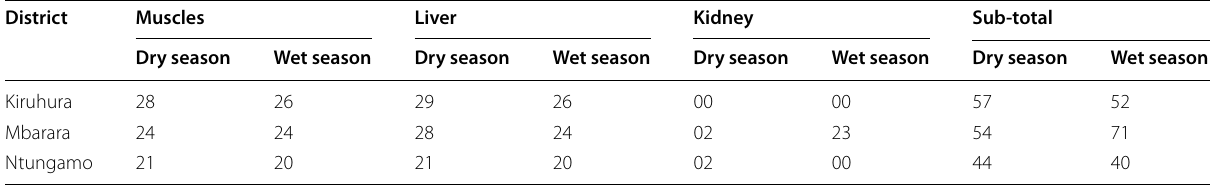
Table 1 Samples of bovine muscles, liver and kidney tissues collected during dry and wet season from South Western Uganda ( N 318) = District Muscles Liver Kidney